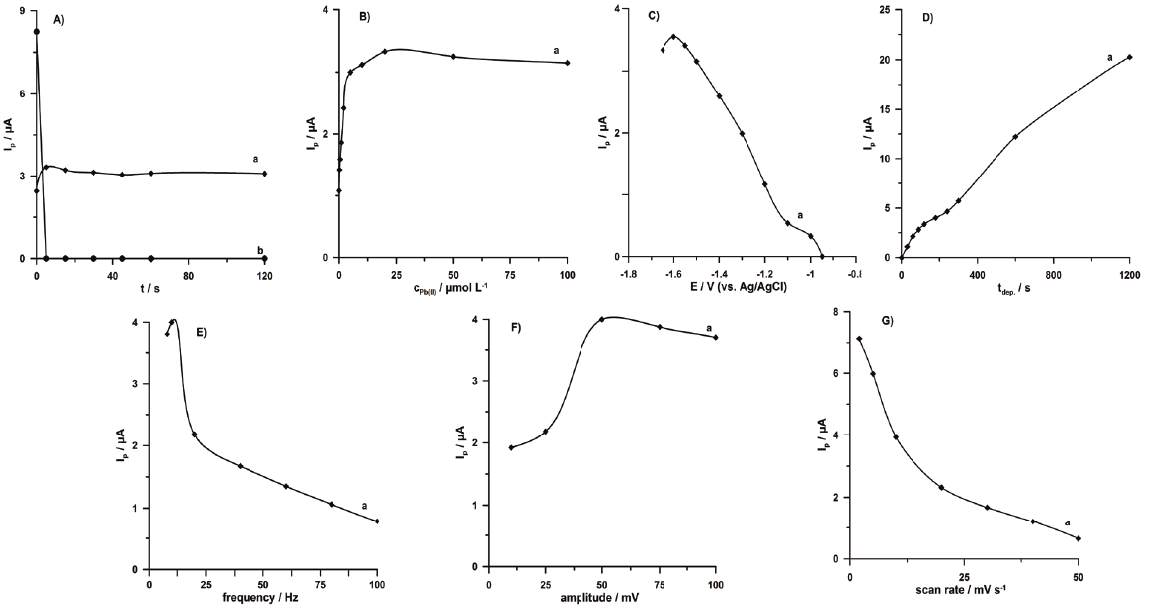
Figure 4. Influence of: A) time of Zn oxidation, B) Pb(II) concentration, C) deposition potential, D) deposition time, E) frequency, F) amplitude, G) scan rate on the voltammetric signal of 5 × 10 -7 mol L -1 Cd(II) (A-G, line a) and on the voltammetric signal of 1 × 10 -5 mol L -1 Zn(II) (A, line